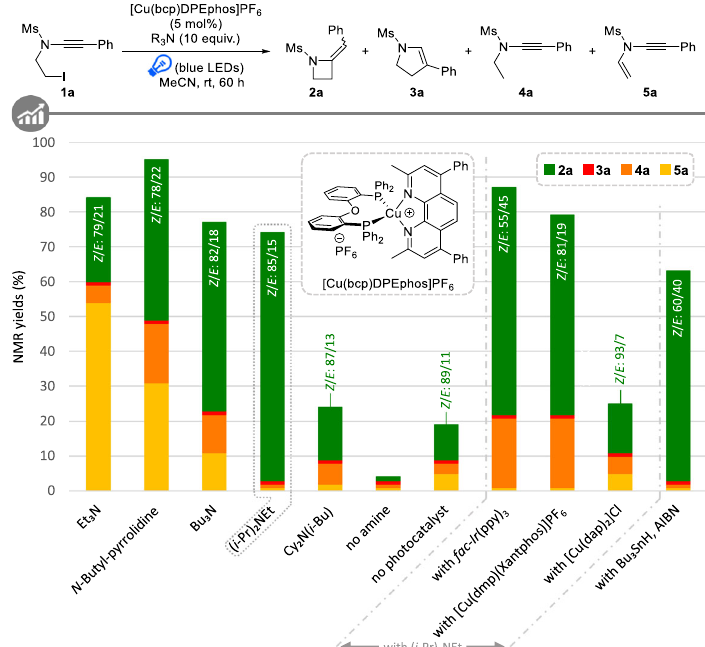
Fig. 2 Optimization of the 4-exo-dig radical cyclization of ynamides to azetidines. Reactions performed on a 0.2 mmol scale. NMR yields and Z / E ratios were determined by 1 H NMR analyses of the crude reaction mixtures using mesitylene as internal